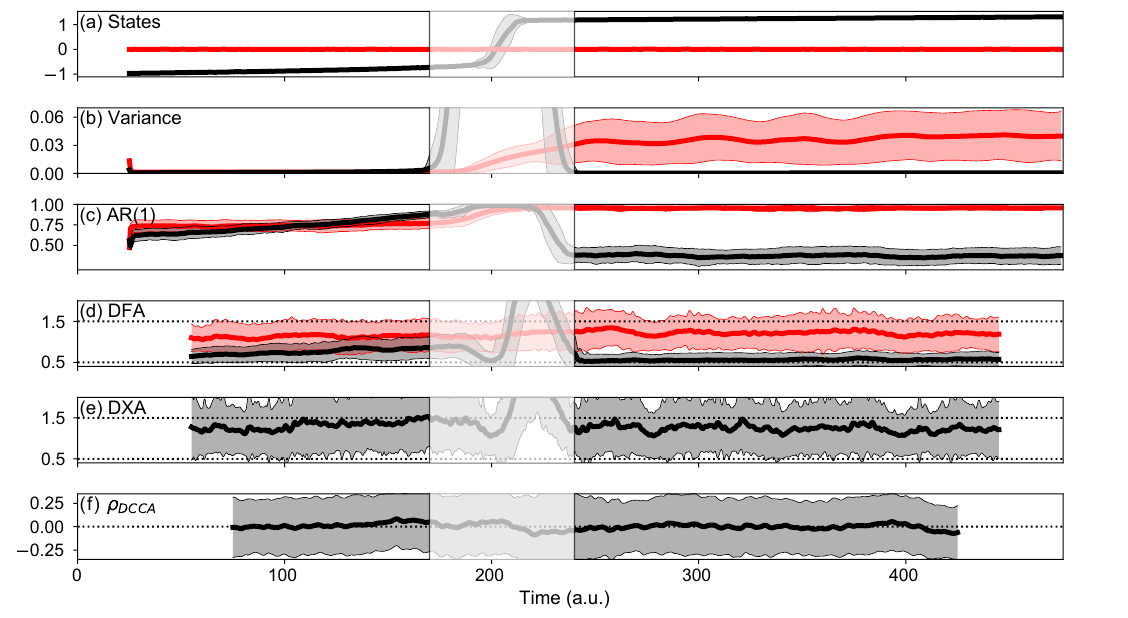
Figure 5. As in Fig. 3, but for the fold–Hopf cascade (Eq. 14). Parameter values are given in Table 2.